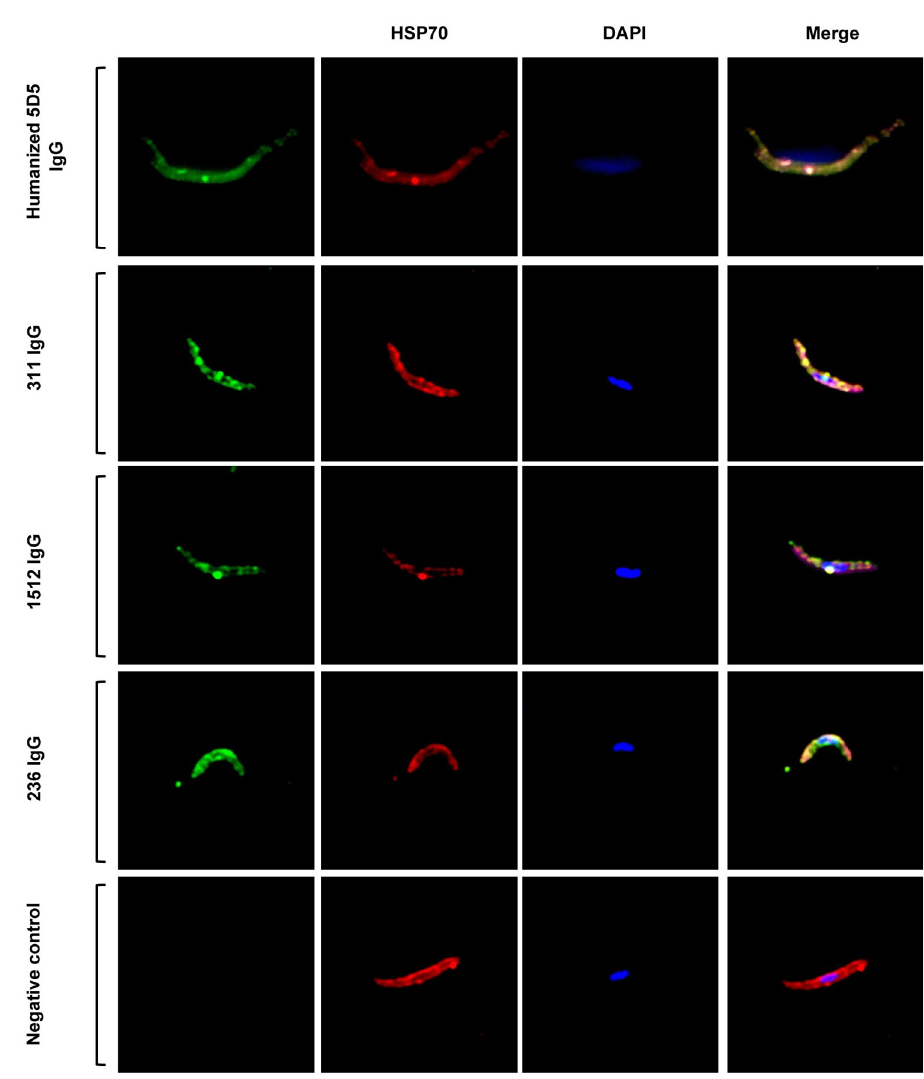
Fig 4. Confocal microscopy images of P . falciparum sporozoites bound by anti-CSP antibodies. P . falciparum sporozoites were dissected from infected mosquito salivary glands and purified. The binding of anti- Pf CSP mAbs specific to N-terminal region of Pf CSP (humanized mAb 5D5), NANP repeats (mAb311), β -ctCSP (mAb1512), and α - ctCSP (mAb236) was observed using the secondary antibody goat-anti-human Alexa 488 (green). A polyclonal anti- HSP70 antibody targeting P . falciparum heat shock protein 70 was used as a positive control and stained with the secondary antibody, goat anti-mouse Rhodamine Red-X (red). The sporozoite nuclei were stained with DAPI (blue). The merged images are also displayed. Images were acquired using a Zeiss LSM880 with Airyscan Confocal Microscope.